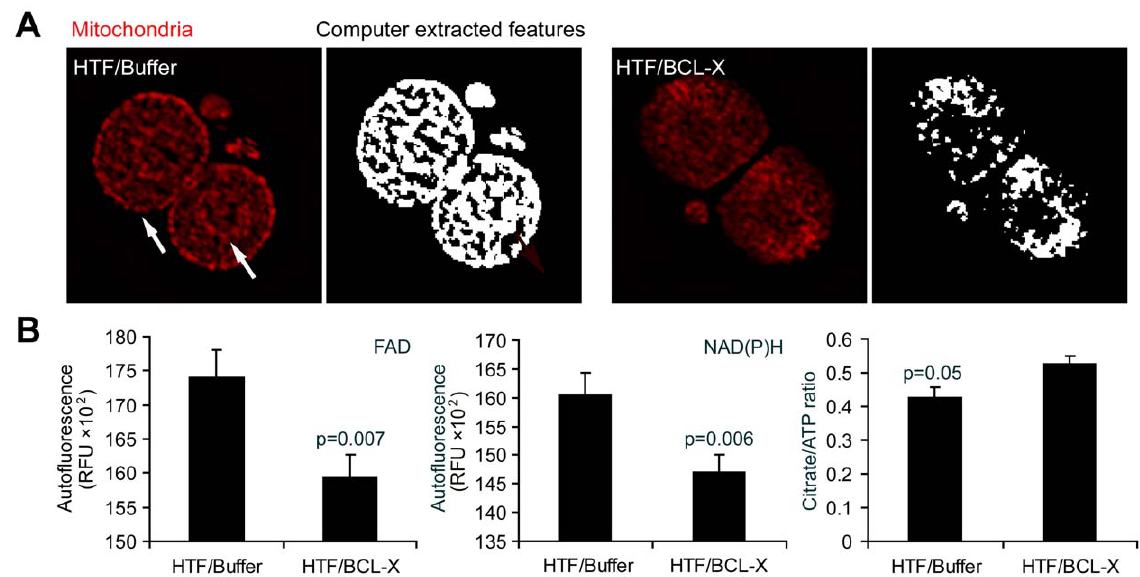
Figure 4. Impact of recBCL-XL ( D TM) microinjection of embryo metabolism and mitochondrial distribution at 2-cell stage. (A) Mitochondrial distribution (Mitotracker Red) at 2-cell stage was evaluated by computerized image analysis approach (extracted features; see Text S1) and compared among cultured conditions. RecBCL-XL ( D TM) protein maintained diffuse mitochondrial pattern (n=30 embryos), while buffer (n=30; similar to HTF culture alone), caused preferential clustering of these organelles to subcortical and perinuclear regions (arrows) of 2-cell embryos maintained in culture for 24 hours. (B) Microinjection of recBCL-XL ( D TM) protein stabilized redox state of 2-cell stage embryos reduced (NAD(P)H and oxidized FAD autofluorescence signal expressed in RFU; n=15 embryos per condition) and improved Krebs cycle outcome (Citrate/ATP ratio n=15 embryos per condition). Student’s t-test was used for statistical analysis. Bars indicate mean 6 s.e.m.